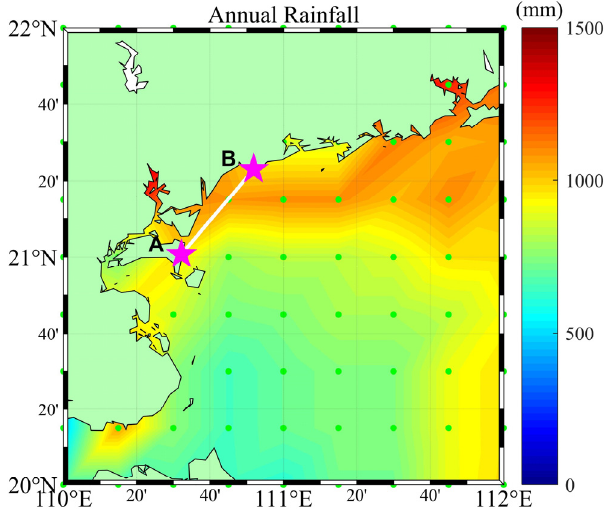
Figure 9. Annual rainfall in the study area (20°–22°N, 110°–112°E) of the SCS in 2021. The green dots represent the grid points of the ERA5 data, the pink five-pointed star A represents Donghai Island and B represents Jizhao Bay.